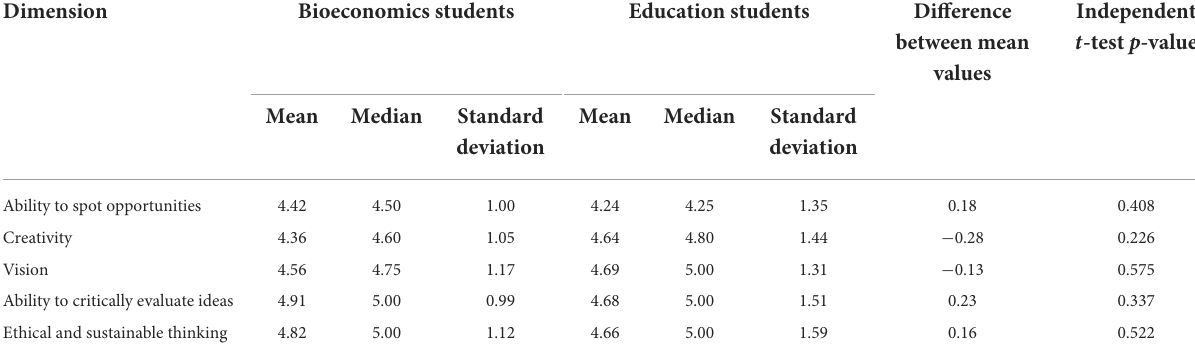
TABLE 4 Results of students’ self-assessment of the problem-solving skills and creativity sub-competence.